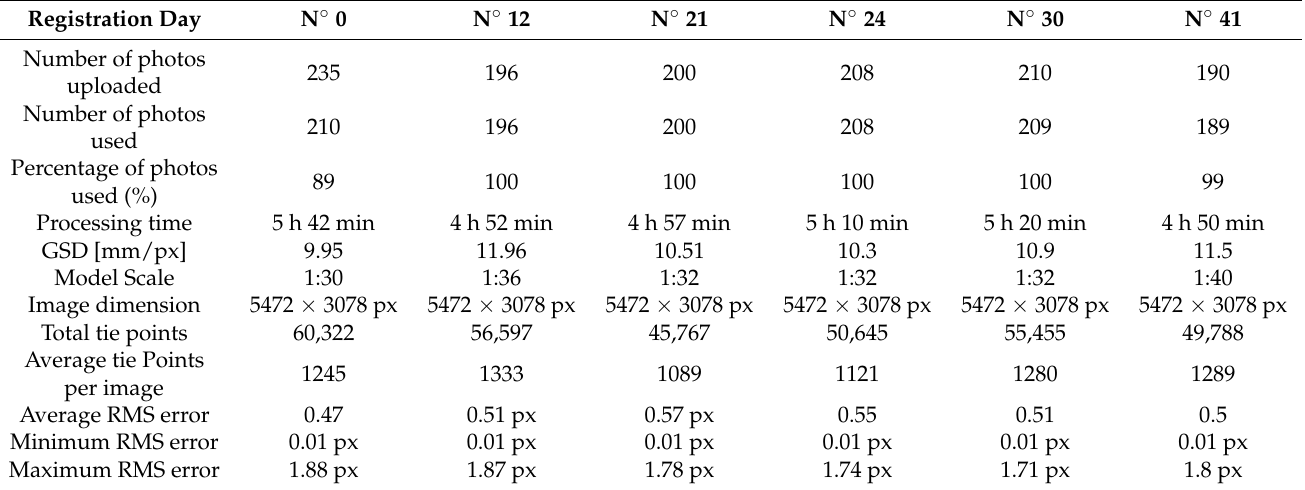
Table 5. Setting model parameters.